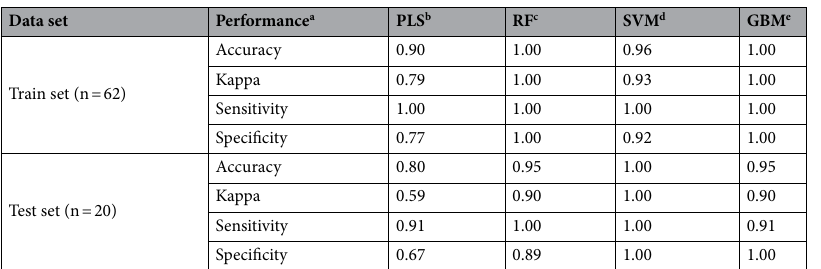
Table 2. Predictive performance of the 4 machine learning approaches in training and testing sets in the present study. a Predictive performance was calculated using confusionMatrix function from caret package in R. b Partial least squares, PLS. c Random forest, RF. d Support vector machines, SVM. e Gradient boosting machine, GBM; PLS, RF, and GBM modeling were performed using caret R package, and SVM modeling was conducted using e1071 R